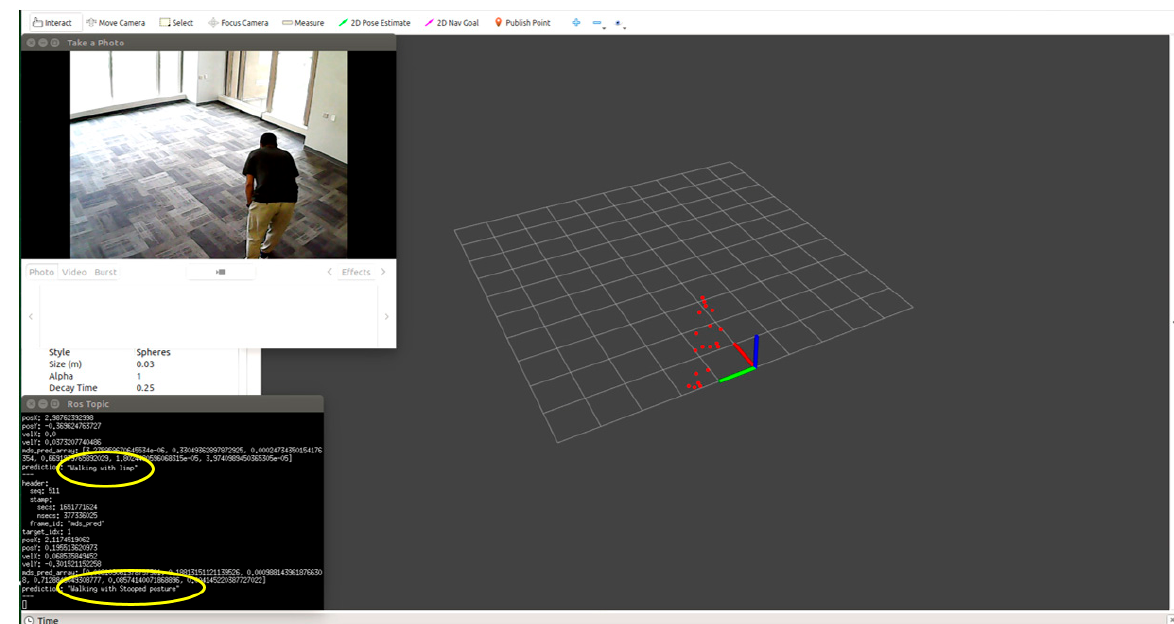
Figure 18. Limping and then stooped posture.